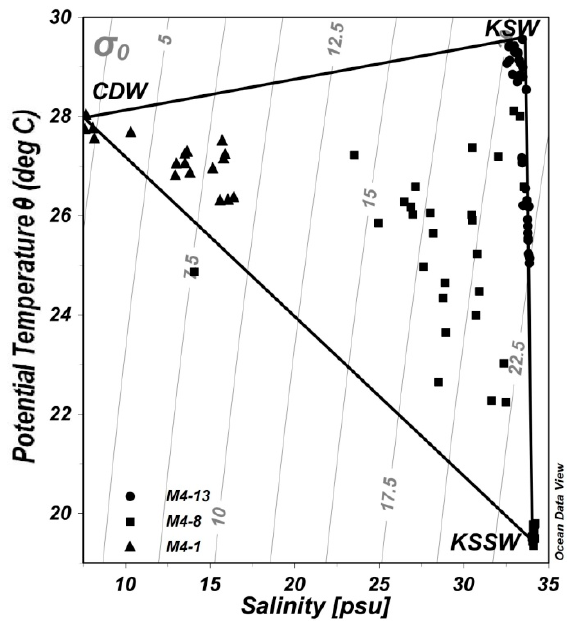
Figure 2. Scatter plots of potential temperature and salinity: M4-1 (triangles), M4-8 (squares), and M4-13 (circles). The labeled vertices denote the three end-members from the three water masses: Changjiang diluted water (CDW), Kuroshio surface water (KSW), and Kuroshio subsurface water (KSSW). Isoclines of potential density are shown in this figure.